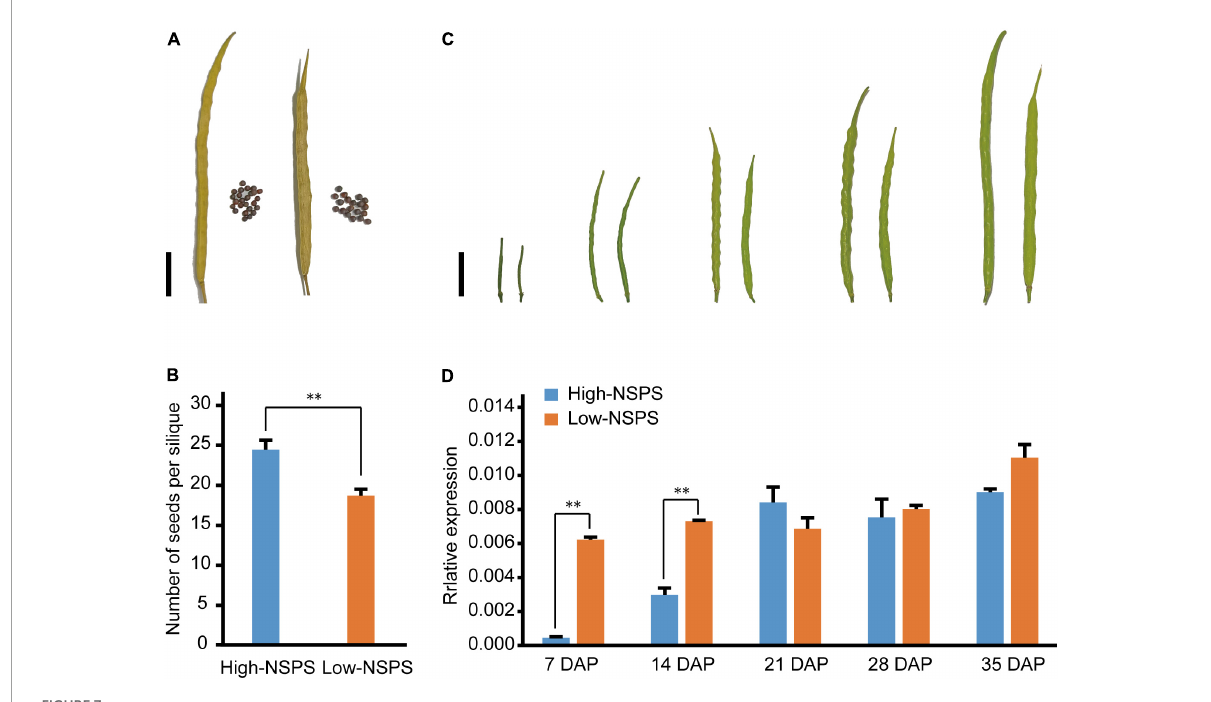
FIGURE7 Phenotype of siliques at different developmental stages and expression levels of BnOFP13_2 in high-NSPS variety and low-NSPS variety. (A) Mature silique of high-NSPS variety (left) and low-NSPS variety (right), bar: 2 cm. (B) Statistical analysis of NSPS in high-NSPS variety